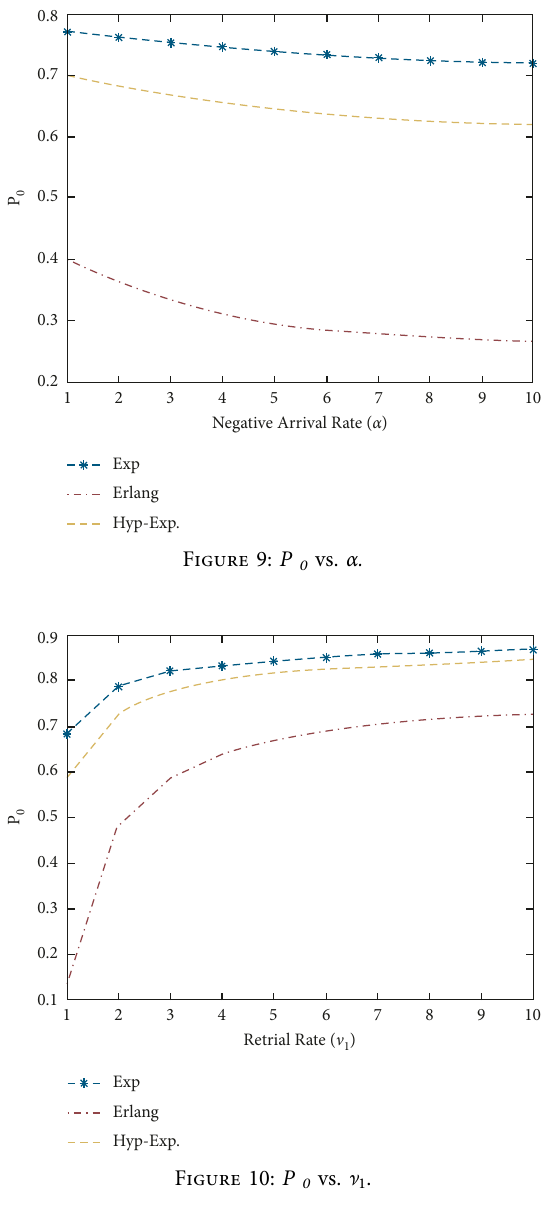
Table 4: The impact of retrial rate ( ]